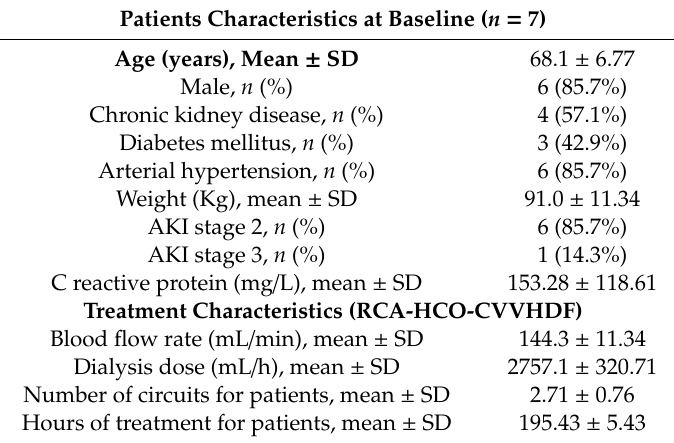
Table 4. Patients and treatments